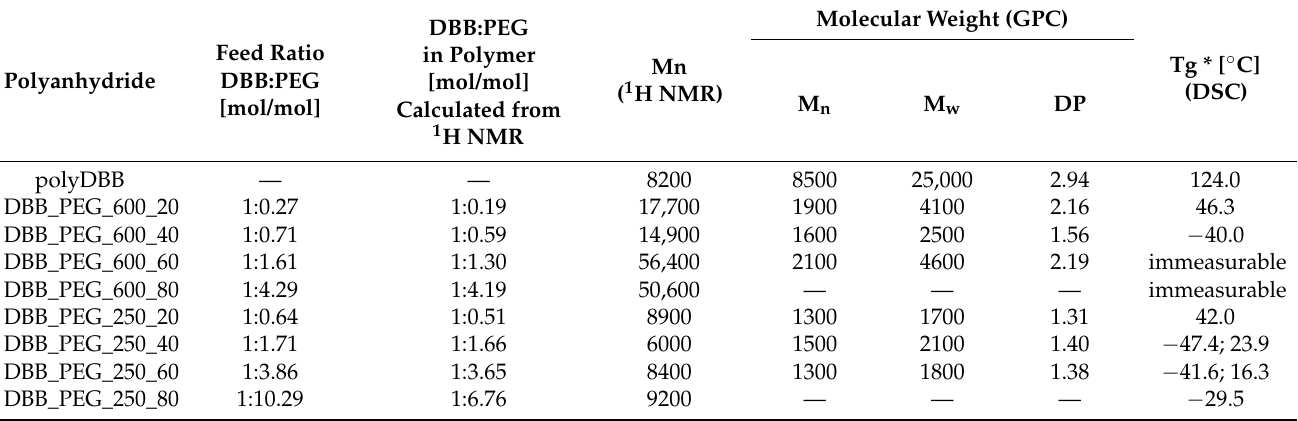
* Tg—glass temperature of polymers determined as a midpoint of glass transition.